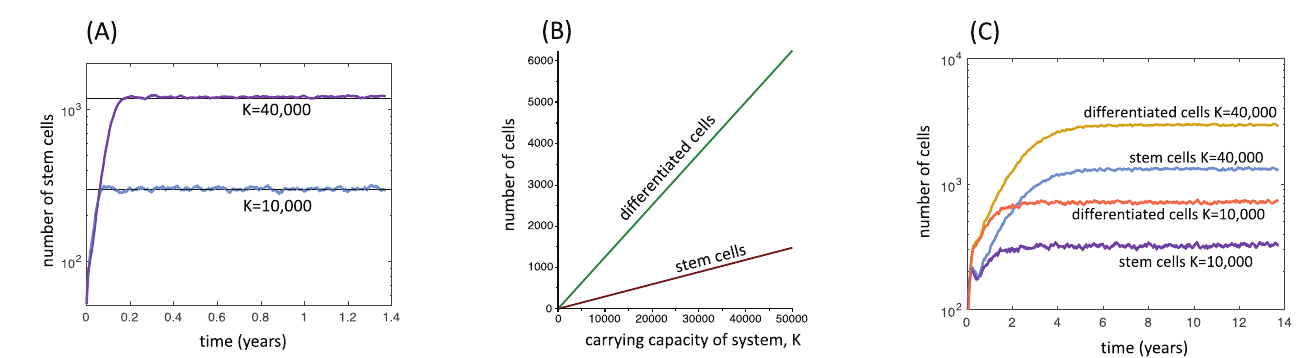
Fig 1. Properties of the spatially explicit computational model with negative feedback. (A) Dynamics of the agent-based model, depending on the carrying capacity K under the assumption that cells migrate with a high rate (large p mig ) and feedback mediators move across space at a high rate (large g ). The horizontal lines represent equilibrium values derived from the corresponding ODE system (2). Parameters are given as follows. For agent-based model: P div = 4.17x10 -2 , p (0) self = 0.7, P Sdeath = 0, P Ddeath = 8.3x10 -3 , p mig = 0.67, h = 1.6, c = 8.33, b = 4.17, g = 83.3; n = 100 and n = 200 for the small and large system, respectively. The average over 46 simulations are shown for each case; standard errors are too small to see. For ODEs: r = 4.17x10 -2 , η = 0, α = 8.3x10 -3 , ξ = 8.33, β = 4.17, p’ = 0.7, f = 1.6, K = 100x100 and 200x200 for the small and large systems, respectively. (B) Equilibrium properties of the corresponding ODE system (2) as a function of the carrying capacity, K. Parameters were the same as in (a). (C) Dynamics of the agent-based simulation, depending on the carrying capacity K under the assumption of spatial restriction (p mig = 0, low g ). Parameters were chosen as follows. P div = 4.17x10 -2 , p (0) self = 0.7, P Sdeath = 8.3x10 -5 , P Ddeath = 4.17x10 -3 , p mig = 0., h = 4.0x10 -3 , c = 8.33, b = 8.3x10 -3 , g = 0.83; n = 100 and n = 200 for the small and large system, respectively. The average over 46 simulations are shown for each case; standard errors are too small to see. Units of parameters are in